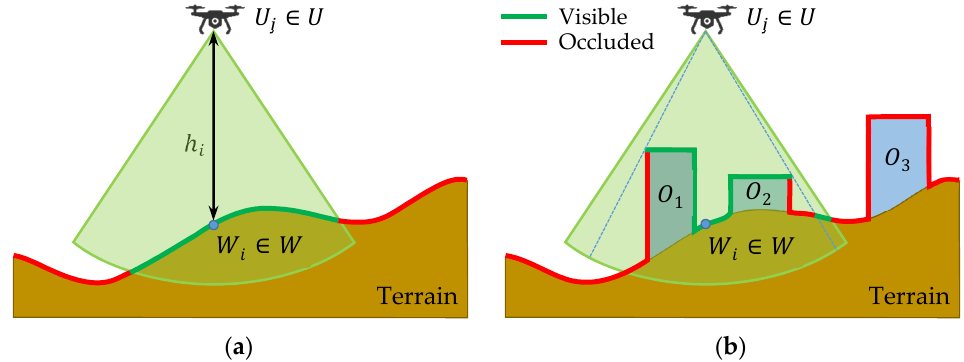
Figure 2. Determination of points monitored by an UAV: ( a ) without obstacles; ( b ) with obstacles.